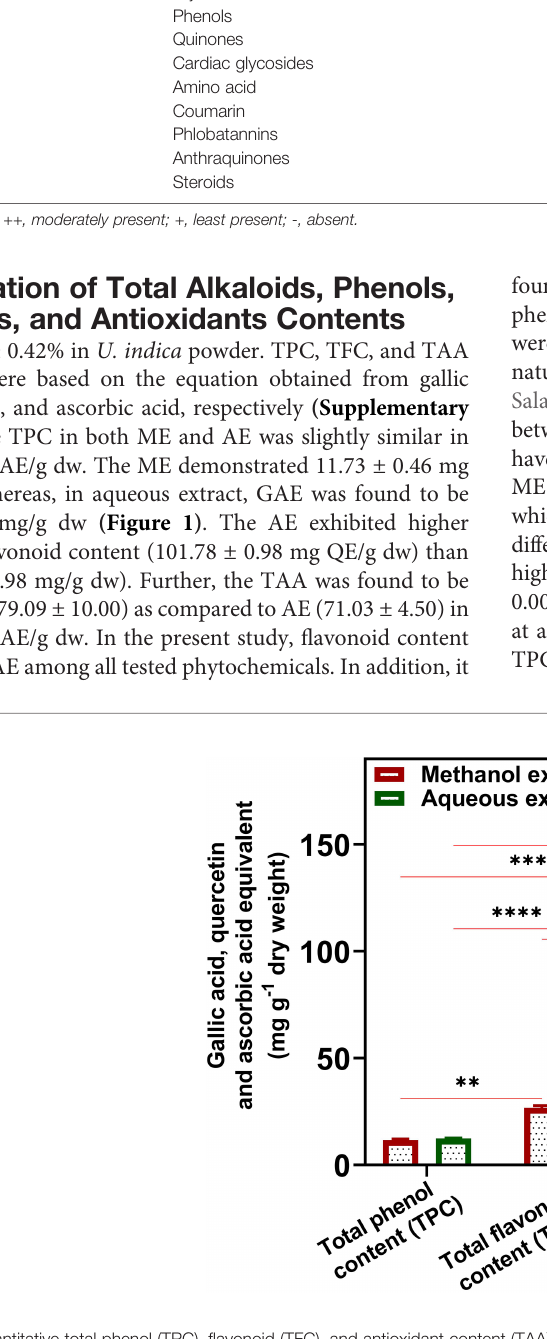
FIGURE 1 | Quantitative total phenol (TPC), fl avonoid (TFC), and antioxidant content (TAA) of U. indica methanol and aqueous extract. Each value is the average of three replicates. The fi gure also represents two-way analysis of variance (ANOVA) among TPC, TFC, and TAA. *, **, and **** represent the signi fi cance at p < 0.05, < 0.001, and < 0.0001,